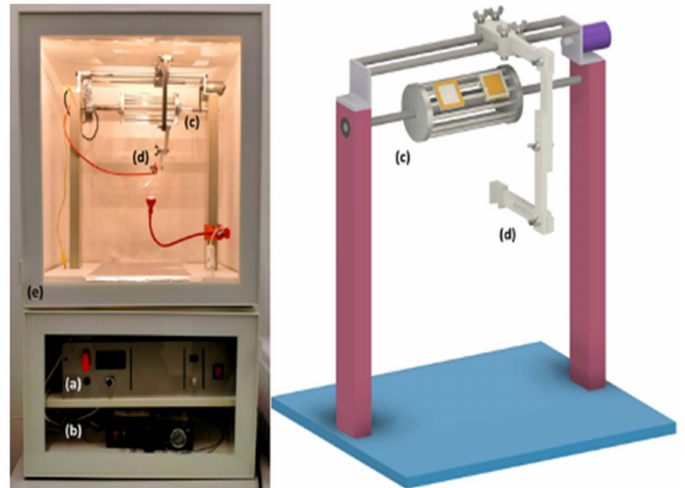
Figure 2. Electrospinning apparatus, consisting of ( a ) high-voltage power supply, up to 50 kV, ( b ) pro- grammable syringe pump for syringes up to 50 mL, ( c ) aluminum cage collector (80 mm × 170 mm) that can spin up to 1k rpm, ( d ) needle positioning system, ( e ) MDF